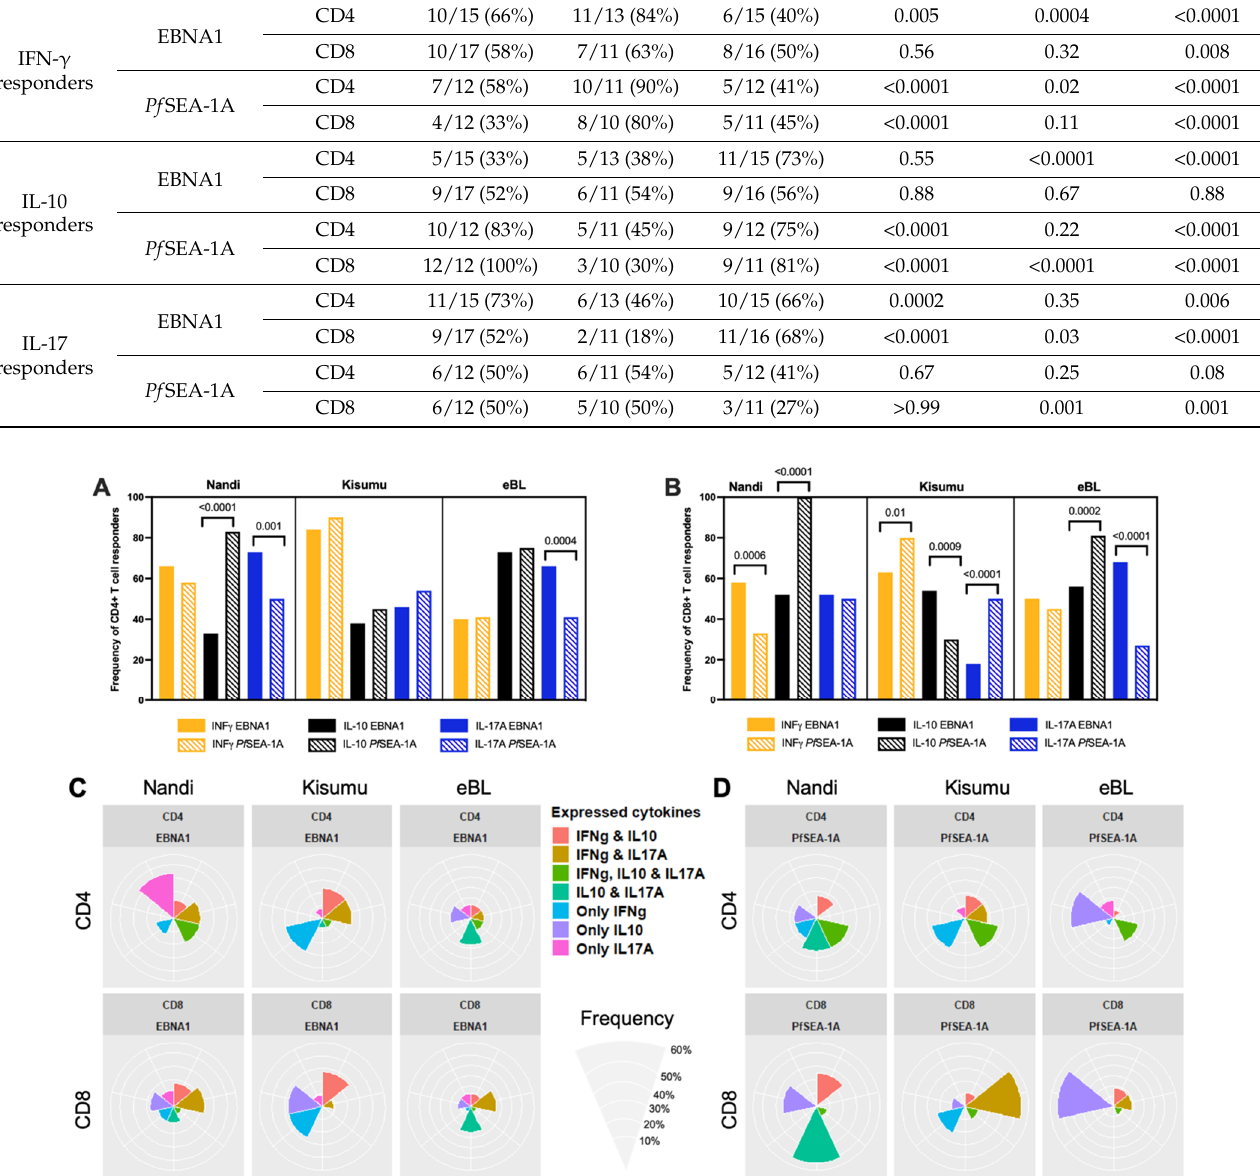
Figure 1. Comparison of cytokine responses for Nandi, Kisumu and eBL children to EBNA1 and Pf SEA-1A. Cytokine (IFN-γ, IL-10 or IL-17A) frequencies to EBNA1 and Pf SEA-1A were compared for ( A ) CD4 + or ( B ) CD8 + T cells within each study group, χ 2 test was applied and p values are indicated. Radar/flower plots represent the cytokine profile (frequency from 0 to 50% for Nandi and Kisumu groups and from 0 to 60% for eBL) within individuals from each group of children from CD4 + and/or CD8 + after ( C ) EBNA1 or ( D ) Pf SEA-1A stimulation. Each petal represents a different combination of cytokine (IFN-γ, IL-10, IL-17A) expression found within individual children. To determine which combinations of cytokine responses to EBNA1 were found within the same individuals and if they differed by malaria exposure or eBL diagnosis,